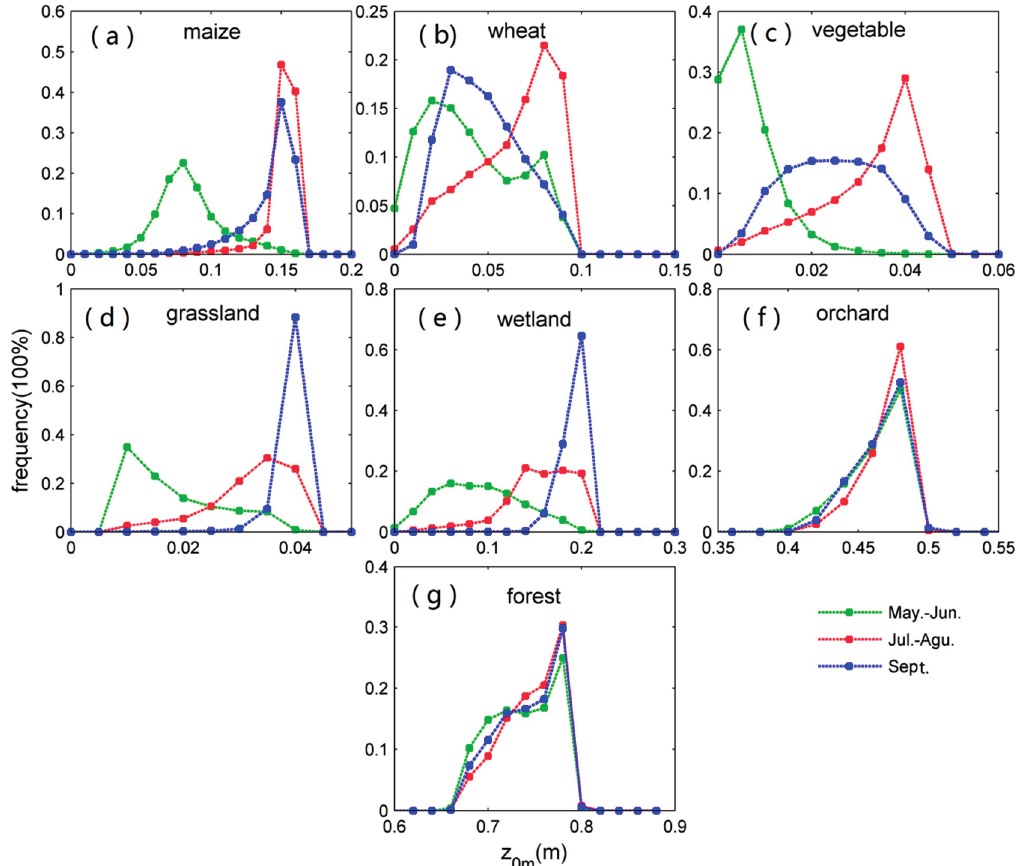
Figure 7. Histograms of z 0m in different growing seasons in 2012 (green curve: May–June; red curve: July–August; blue curve: September) for the different vegetation types over the study area (middle reach of Heihe River Basin): ( a ) maize; ( b ) wheat; ( c ) vegetable; ( d ) grassland; ( e ) wetland; ( f ) orchard and ( g )